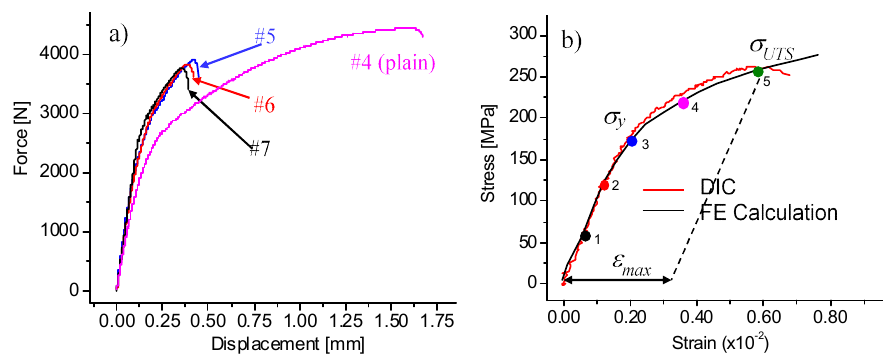
Figure 9. Tensile testing of notched specimens: ( a ) force–displacement diagrams obtained for three notched and one plain specimens; ( b ) stress–strain diagram of Specimen #7 (simulation and testing); numbers 1 to 5 indicate different reference points along the stress–strain plot.